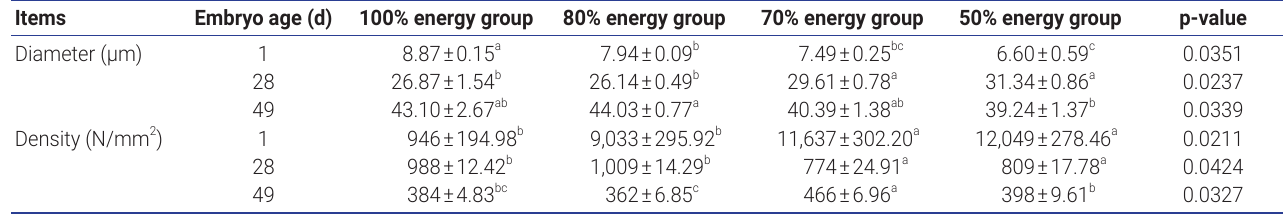
Table 5. Effects of maternal dietary energy restriction on diameter and density of breast muscle fiber in the offspring